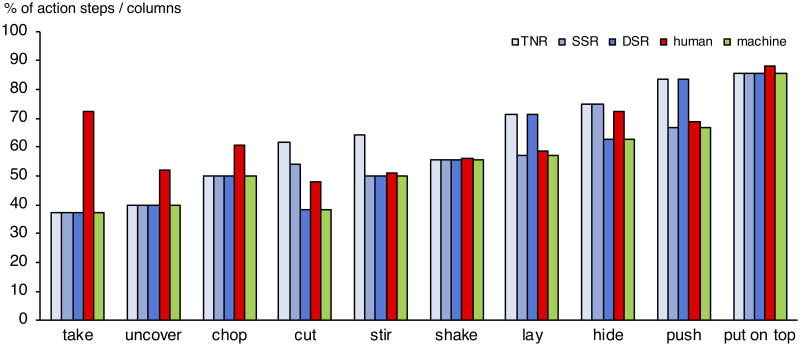
Comparison of human (red bars) and machine (green bars) predictive performance.Blue bars indicate the relative amount (percentage) of action steps elapsed per action, before the TNR (light blue), DSR (blue) or SSR (dark blue) model provided maximal local informational gain, enabling a secure prediction of the respective action. For instance, the 5th eSEC-column of the overall 13 eSEC-columns describing the cut action provided a unique description in terms of DSR. That is, after around 38% of these action’s columns, the cut action could be predicted on the basis of DSR information, and this is what the algorithm did, as indicated by the green bar of equal length. In contrast, humans correctly predicted the cut action at the 6th (mean 6.26) column, corresponding to 48% of this action, exploiting both dynamic and static spatial information (cf. Fig 5 for this outcome).